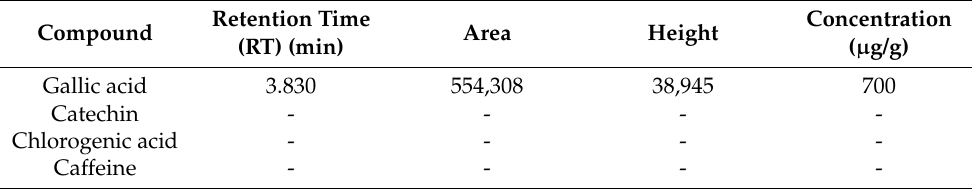
Table 3. Contents of individual flavonoids and phenols ( µ g/g) of Rumex nervosus determined by HPLC.